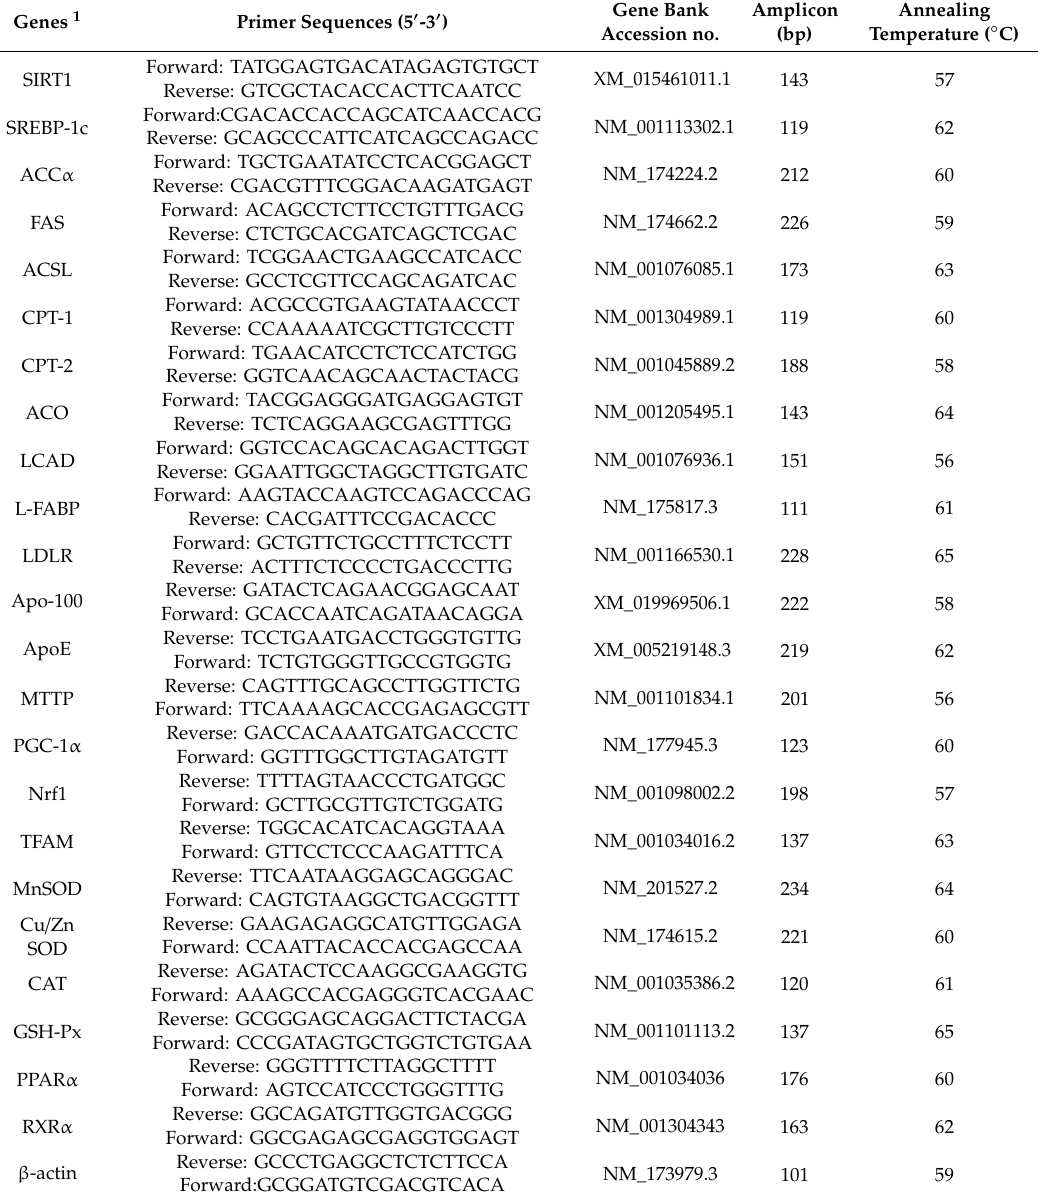
Table 3. Primers sequences qRT-PCR used in this